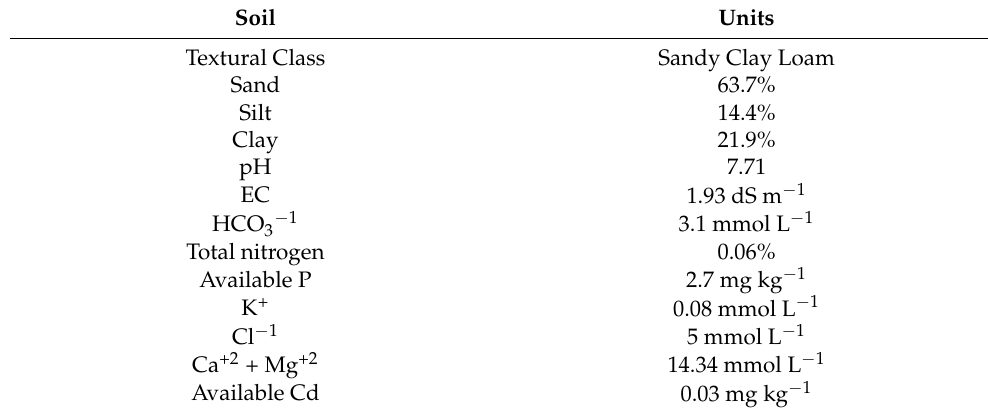
Table 1. Physico-chemical analysis of soil used for this experiment.